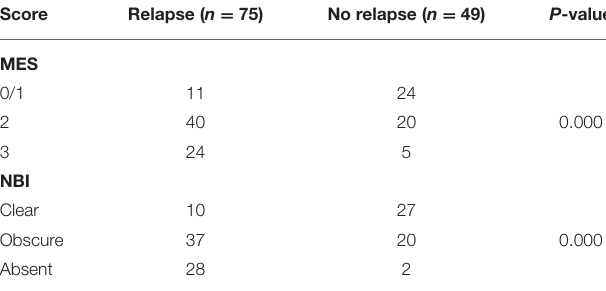
TABLE 5 | Clinical relapse by endoscopic score.